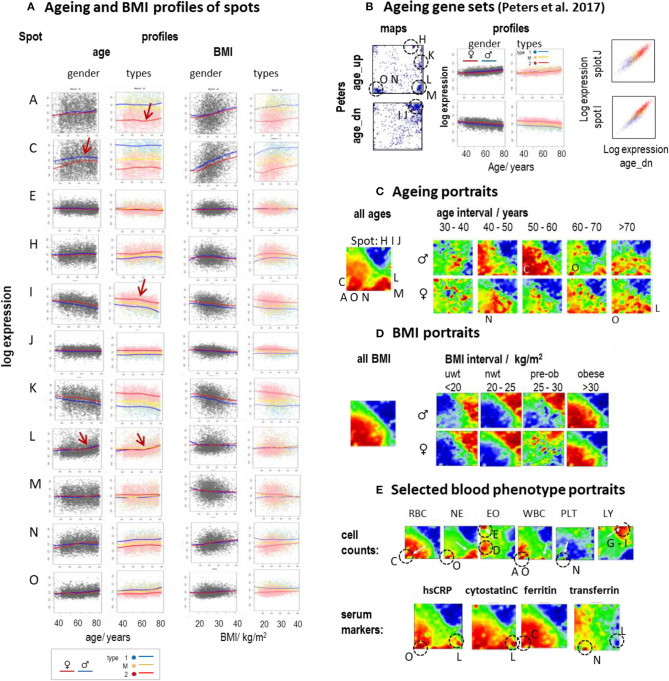
Aging and BMI characteristics of the blood transcriptome: (A) Expression of selected spots as a function of age and BMI. Separate LOESS (local weighted scatterplot smoothing) fits for women and men (red and blue curves) and for types 1, M, and 2 visualize mean spot expressions as a function of age and BMI. The course is mostly non-linear and change slope at different turning points (see arrows). (B) Genes from previous aging sets (Peters et al., 2015) spread either over a heterogeneous (age_up) or a more homogeneous (age_dn) distribution of spots (letters and dashed circles). The latter set correlates with the expression of spots I and J (correlation plots at the right). (C) The overall aging portrait (of correlations between the ages of the participants and the transcriptome “metagene” landscape) roughly can be understood as superposition of (increasing with age in red) RBC- and NE-like fingerprints and (decreasing with age in blue) LY-patterns. Stratification into decade intervals shows that NE-fingerprints apply mainly to elderly people (>60 years) while elevation of RBC is relevant mostly for participants younger than 60 years. (D) Portraits of different BMI strata reveal the continuous change from type 2 (under- and normal-weight participants) to type 1 (obese) transcriptomes. (E) Selected blood cell count and serum marker portraits reveal fingerprint-like patterns. Characteristic “landmark” spots are indicated by dashed circles and the respective spot letters.